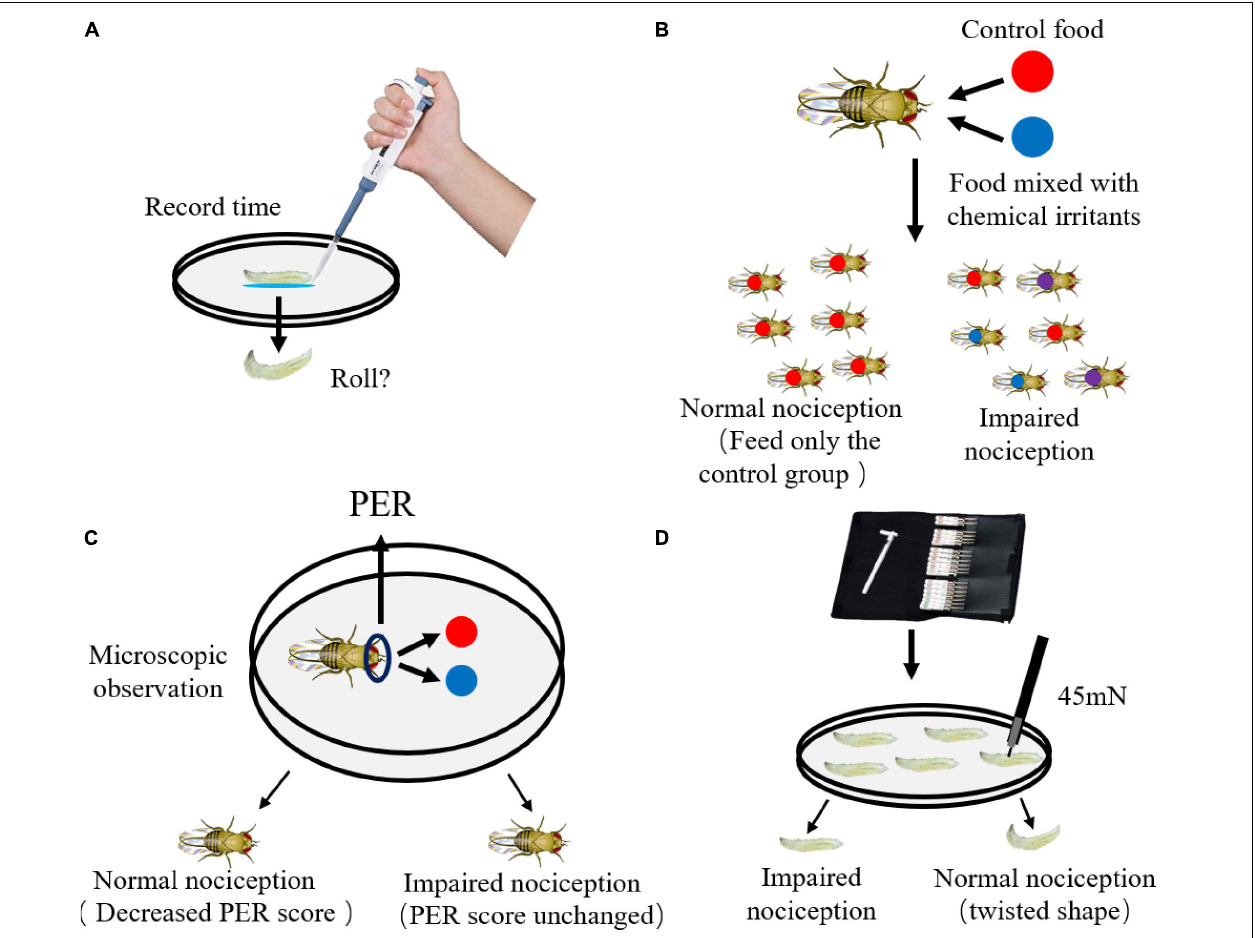
FIGURE 2 | Detection method of chemical and mechanical nociception in Drosophila . (A) Use a pipette to place the chemical stimulus around the body of the larvae and record the incubation period. (B) Adult flies with impaired nociception eats indiscriminately, while wild-type flies eat only control food. (C) Provide two kinds of food and record the PER score of adult flies. (D) The von Frey fiber was calibrated and used for the determination of mechanical nociception: wild-type adult flies will have a rolling response when the force exceeds 45 mN, and the adult flies with impaired nociception have a greater rolling